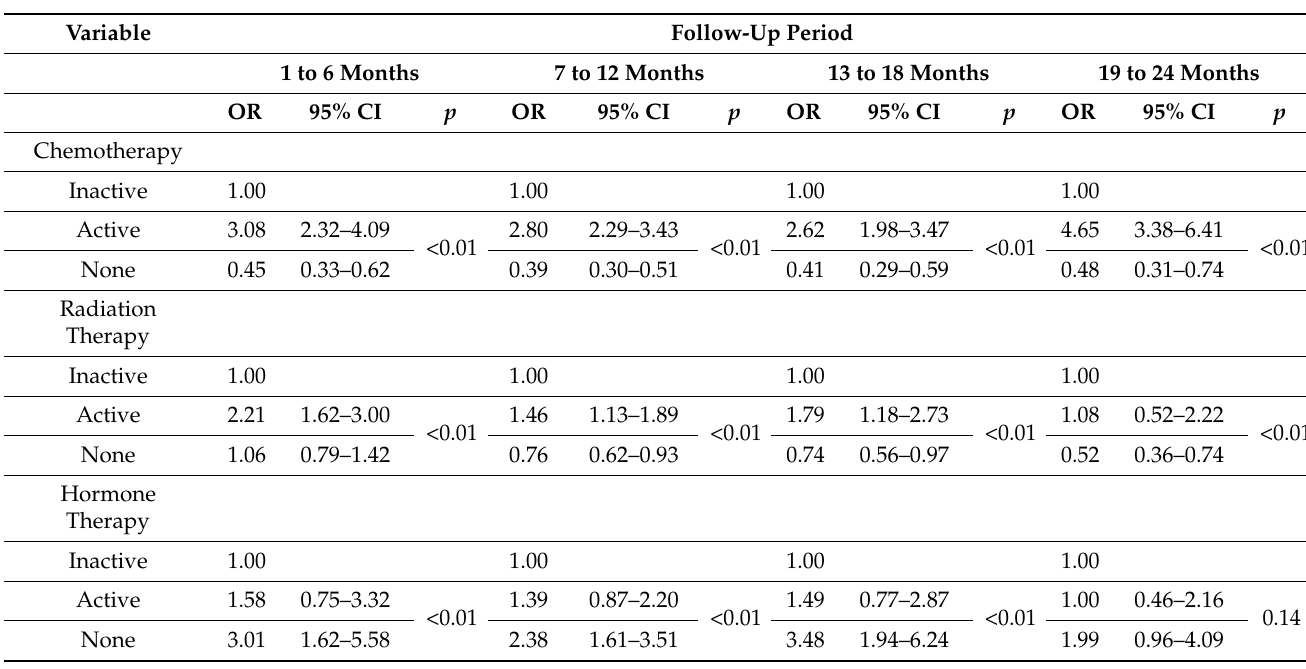
were not receiving chemotherapy in all follow-up periods (Table 2). Table 2. Multivariable logistic regression model describing factors associated with UCC visits stratified by follow-up time